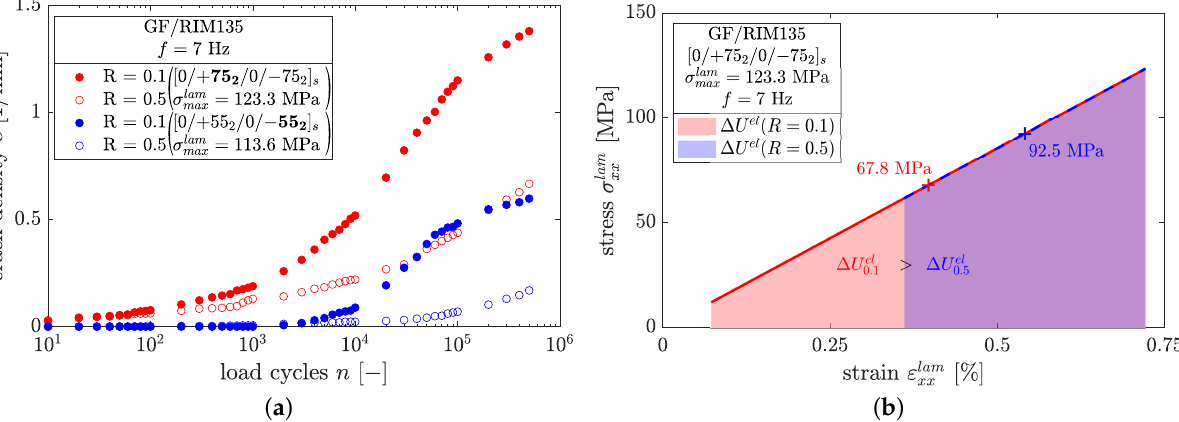
Figure 12. Influence of ( a ) load level, ( b ) load ratio, ( c ) fiber orientation, and ( d ) ply thickness on the formation and growth of microcracks under fatigue loading.